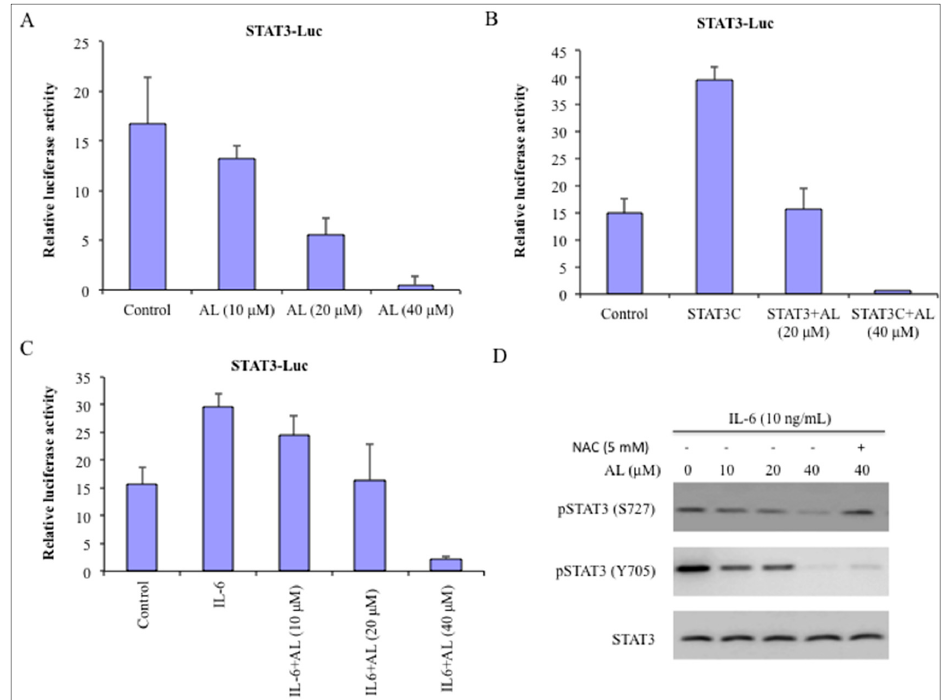
Figure 5. Altholactone inhibited constitutive, IL6- and STAT3C-induced STAT3 transcriptional activity and STAT3 phosphorylation in DU145 cells: ( A ) the effect of altholactone on the STAT3 transcriptional activity. DU145 cells were transiently transfected with M67-Luciferase plasmid. After 16 h of transfection, cells were treated with the indicated concentrations of altholactone for 8 h and then harvested for luciferase and β -galactosidase assays; ( B ) The effect of altholactone on IL-6-enhanced transcriptional activity of STAT3. At 16 h after transfection, cells were treated with the indicated doses of altholactone for 8 h and then prior to harvest for luciferase and β -galactosidase assays, cells were treated with IL-6 for stimulation; ( C ) DU145 cells were co-transfected with M67-Luc construct and the expression plasmid for constitutive STAT3 (STAT3C). At 16 h after transfection, cells were treated with altholactone for 8 h then harvested for luciferase and β -galactosidase assays. Data are the means of three independent experiments, each performed in duplicate; ( D ) Altholactone inhibited phosphorylation of STAT3 at Tyr705 and Ser727. Serum-starved cells for 24 h followed by altholactone treatment (10, 20 and 40 µM) for 8 h prior to stimulation with IL-6. To examine the role of ROS, cells were pre-treated with NAC (5 mM) for 2 h followed by altholactone (40 µM) treatment. Cells were harvested for western blotting using antibodies against pSTAT3 (Y705), pSTAT3 (S727), and STAT3.Data are the representative of three independent experiments.